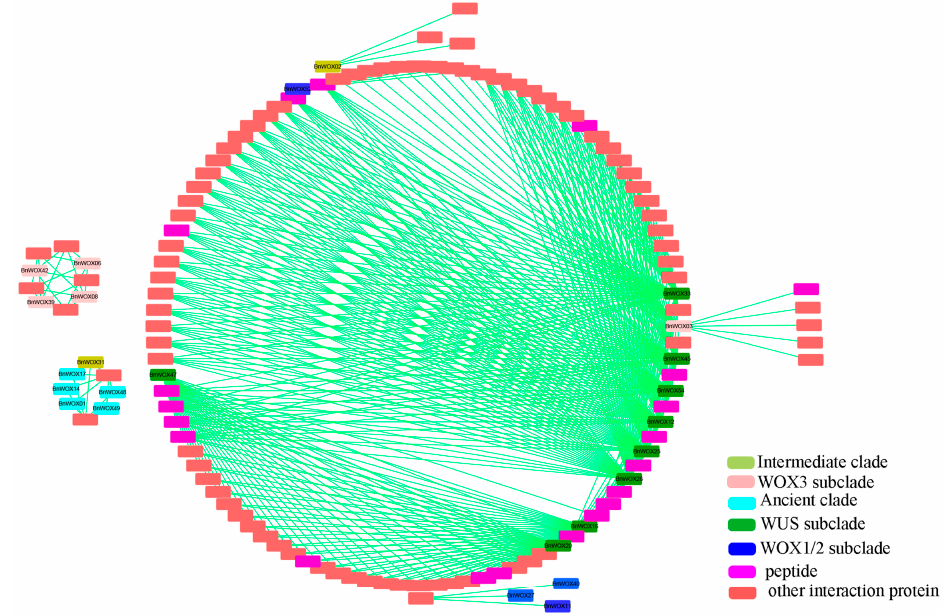
Figure 5. Protein interaction network of BnWOXs in B. napus . Different color blocks show BnWOXs from different clades and subclades, as well as different types of interacting proteins.